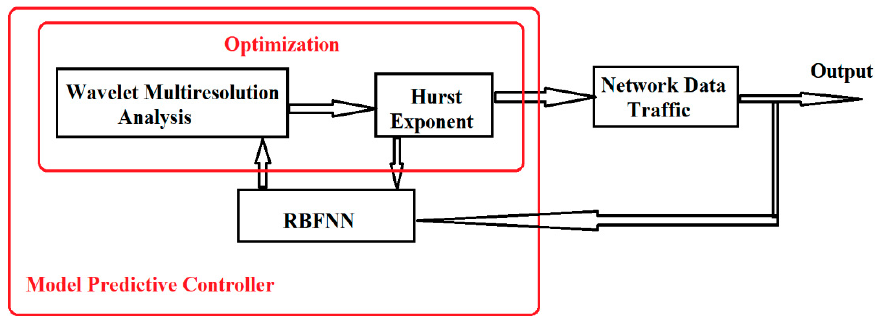
Figure 14. MPC based on RBFNN for each data network.